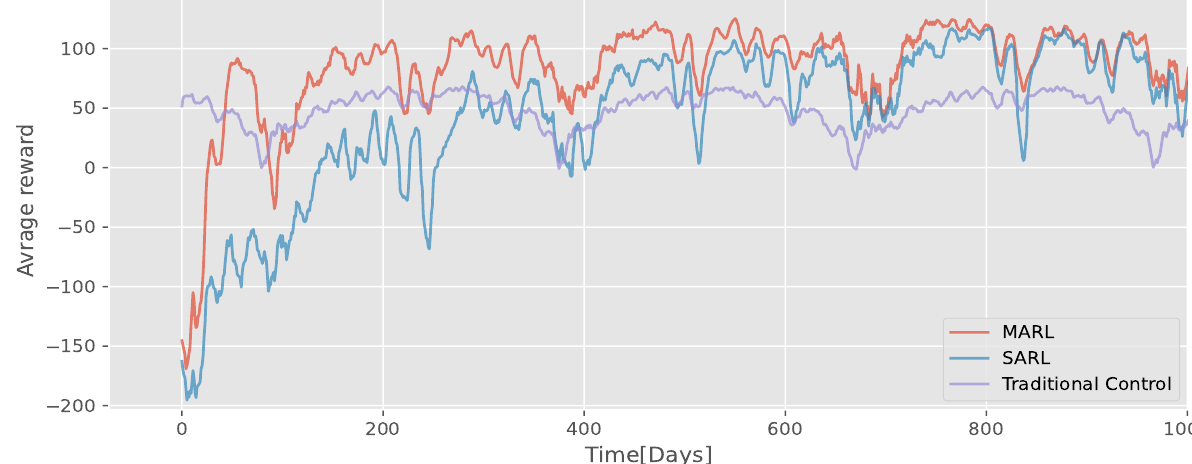
Figure 9. Reward signal of the four-zone UFH system in, simulation time is 1000 days (working on 2000-day simulation